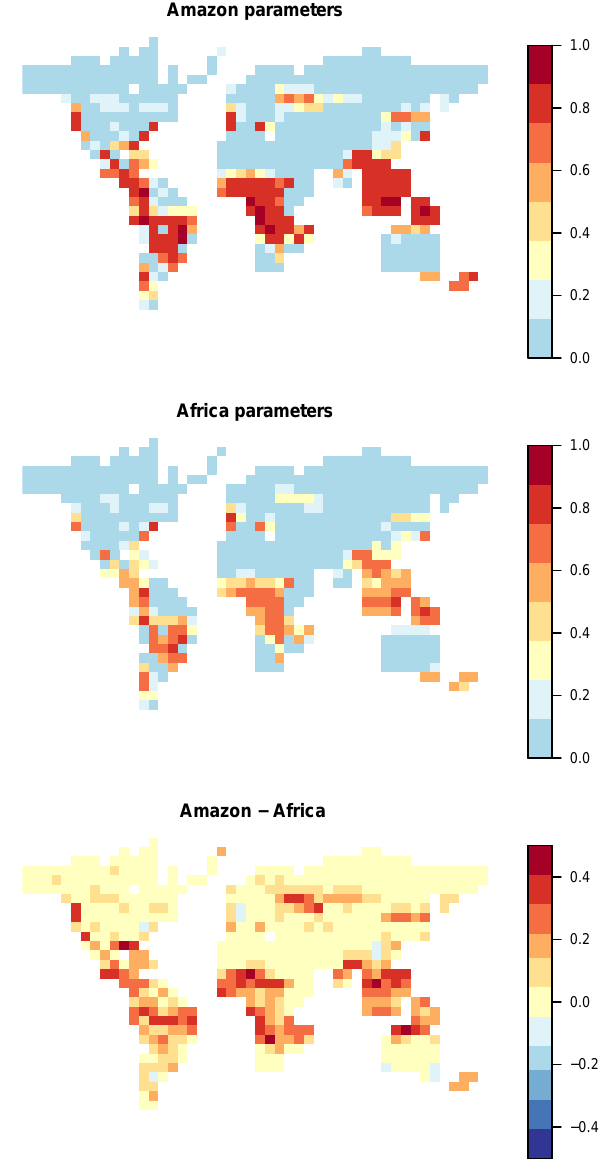
Figure 12. Maps of mean broadleaf forest fraction, over the “best” set of parameters found for the Amazon (top panel) and the Cen- tral African forest (centre panel). The difference between the two is mapped at the bottom